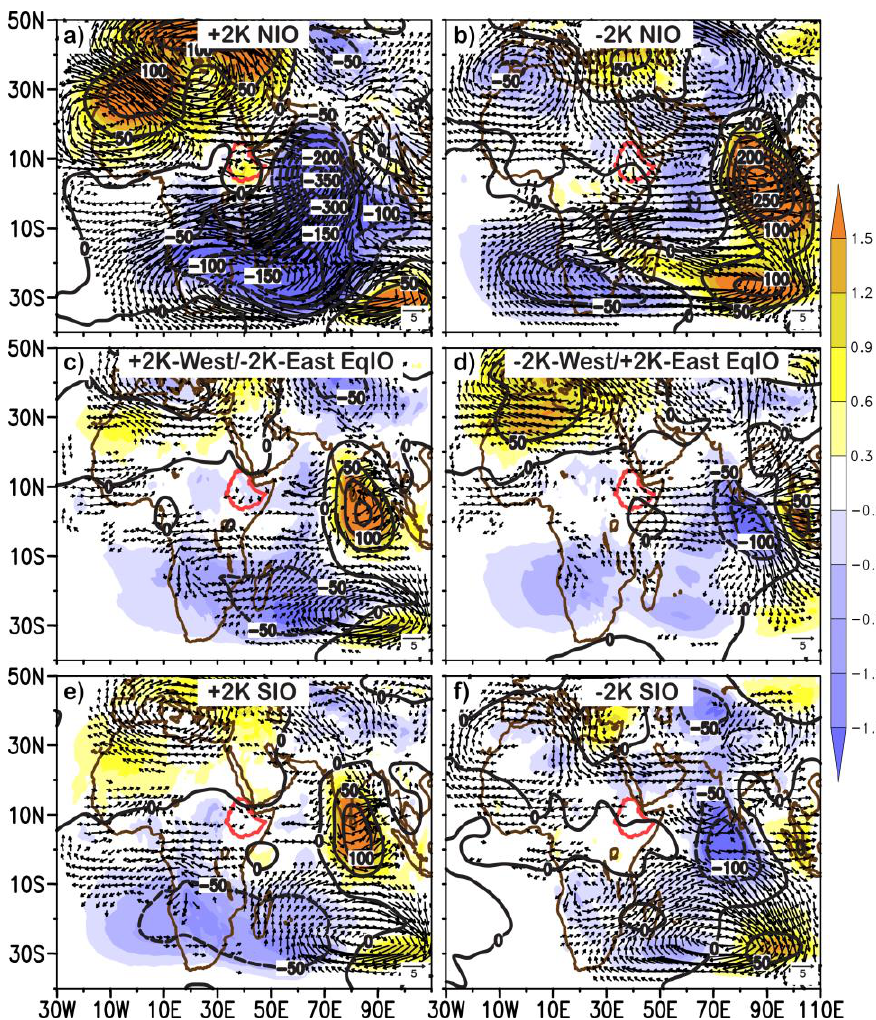
Figure 8. Circulation changes from CNTL at 150 hPa averaged for July-August corresponding to SST anomaly (SSTA) forcing over the ( a , b ) Northern Indian Ocean (NIO; 0°–25°N, 40°–75°E); ( c , d ) Equatorial Indian Ocean (EqIO; 10°S–10°N, 70°–100°E); and ( e , f ) Southern Indian Ocean (SIO; 10°–40°S, 30°–80°E). Each panel shows differences in horizontal winds (vectors; m·s −1 , magnitude scale in lower right corner), temperature (shading; K, color scale at right), and geopotential height (contours; gpm) between the perturbed SSTA forcing experiments and CNTRL. Differences of geopotential heights are contoured every 50 gpm. Anomaly vectors are plotted for resultant magnitudes of at least 1 m·s −1 only. The border of Ethiopia is delineated in solid red line. See Table 1 for description of